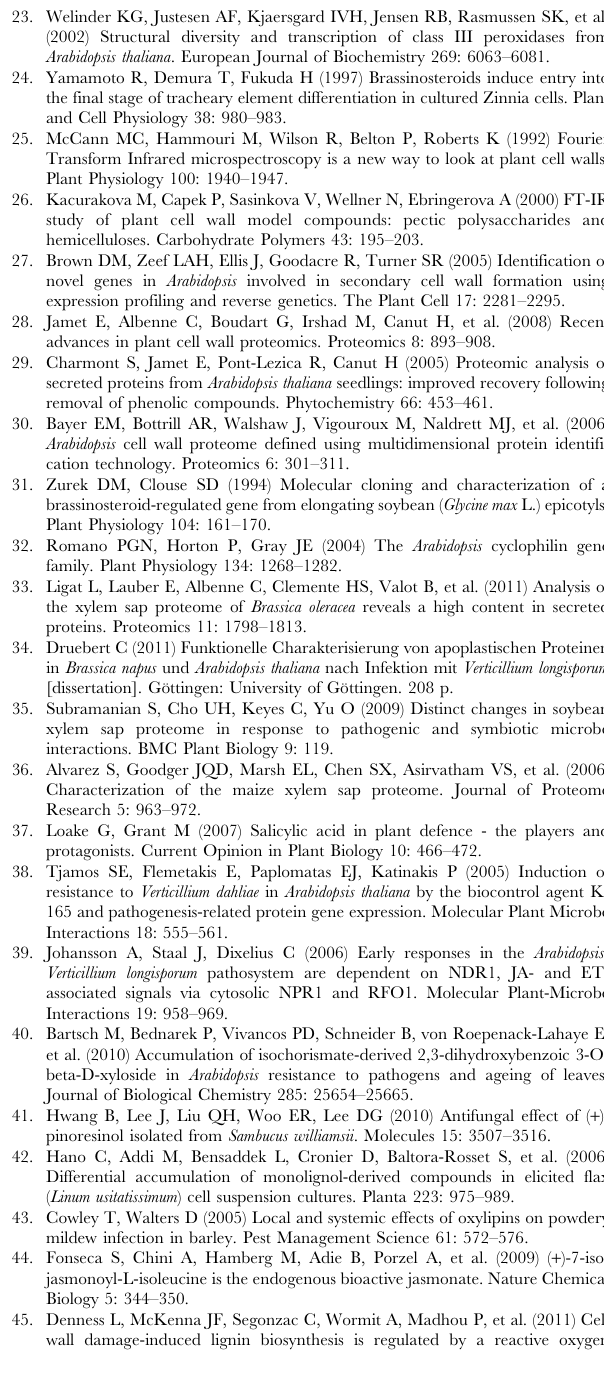
Table S2 Proteome analysis of major proteins in whole leaf extracts of Arabidopsis thaliana . Table S3 Original metabolome data set. (XLS) Table S4 Primers used for verification of expression changes of VL-responsive